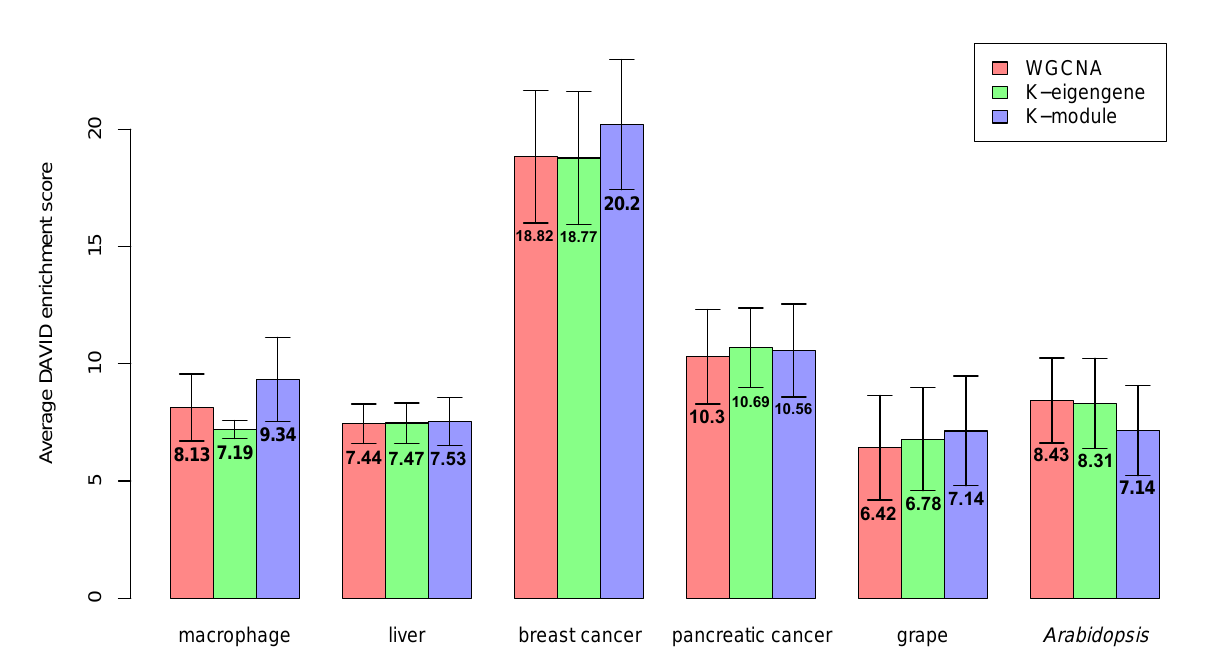
Figure 3. Average Database for Annotation, Visualization, and Integrated Discovery (DAVID) enrichment score of modules obtained by WGCNA, k-eigengene, and k-module algorithms. The enrichment score obtained by the k-module algorithm was the highest in most of the